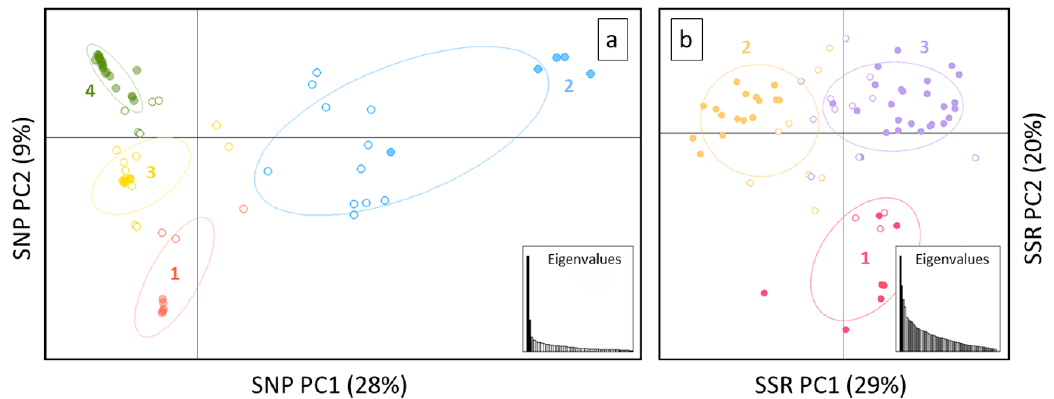
Figure 3. Principal component analysis (PCA) of the grapevine rootstock core collection (66 genotypes), defined using 14k SNP ( a ) and 17 SSR ( b ) molecular markers. Genotypes are classified according to the ancestral groups identified in the structure analysis. White filled dots are admixed genotypes. Colors are according to ancestral groups reported in Figure 2.